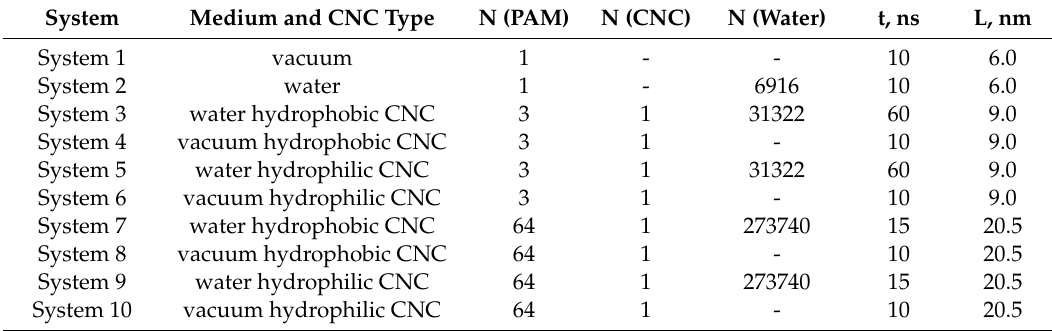
Table 1. Simulation details of di ff erent systems: the number (N) of PAM, CNC, and water molecules, simulation time (t, ns), length of box (L,